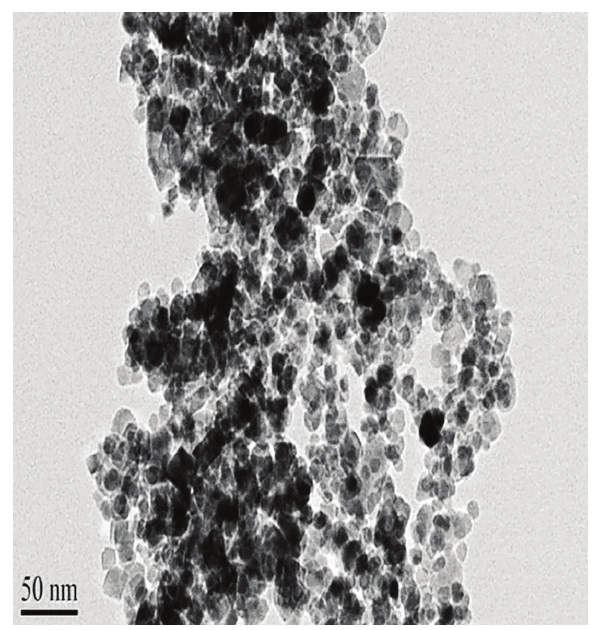
Fig. 1 – TEM image of the purchased Fe